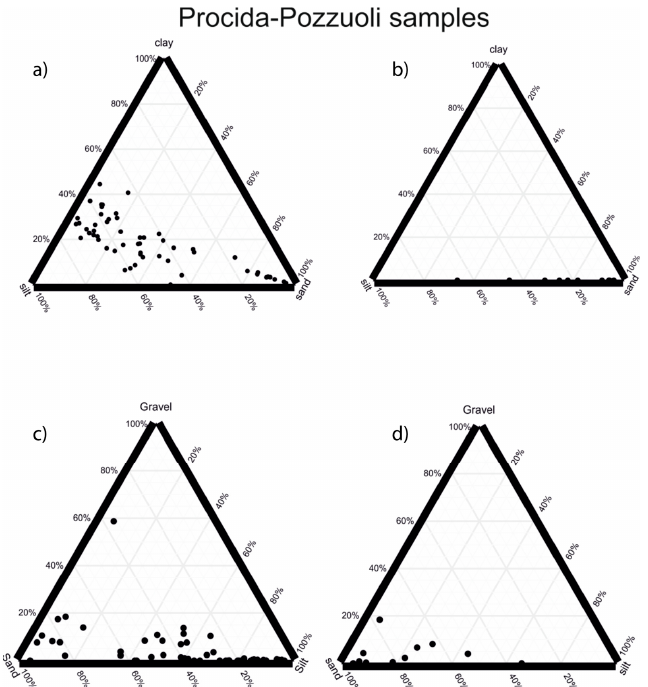
Figure 6. Ternary plots of the sea bottom samples constructed at Procida–Pozzuoli. ( a ) ternary plot (clay–sand–silt), ( b ) ternary plot (clay–sand–silt); ( c ) ternary plot (gravel–sand–silt); ( d ) ternary plot (gravel–sand–silt).